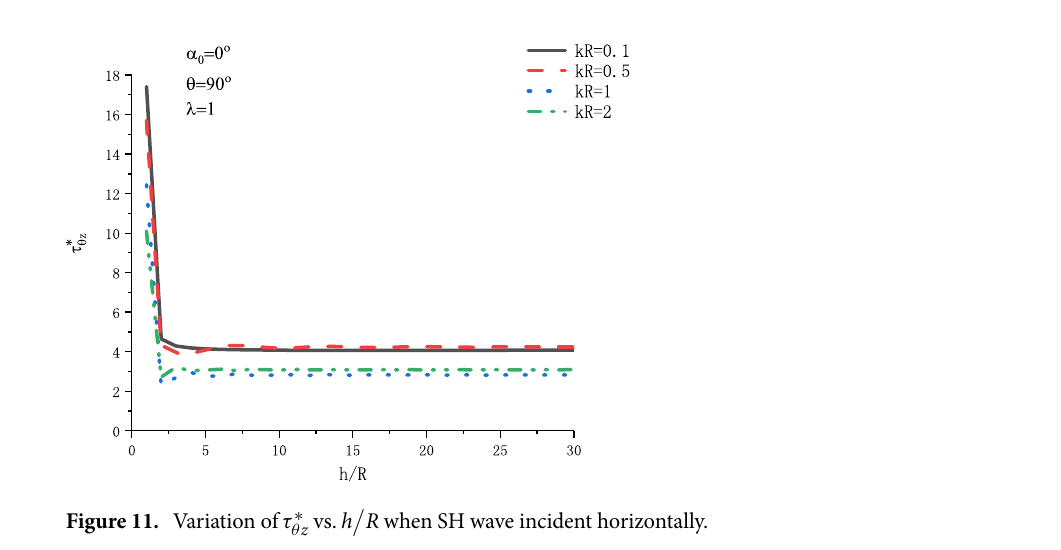
Figure 10. Variation of τ ∗ θ z vs. kR when SH wave incident vertically.